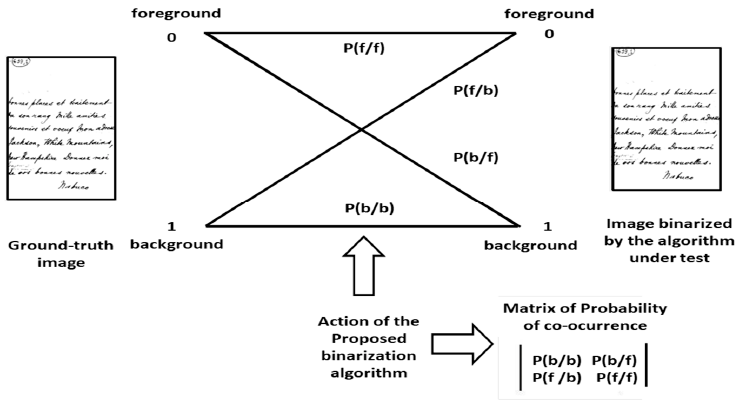
Figure 3. Generation of the co-occurrence matrix for each of the images in the training set.